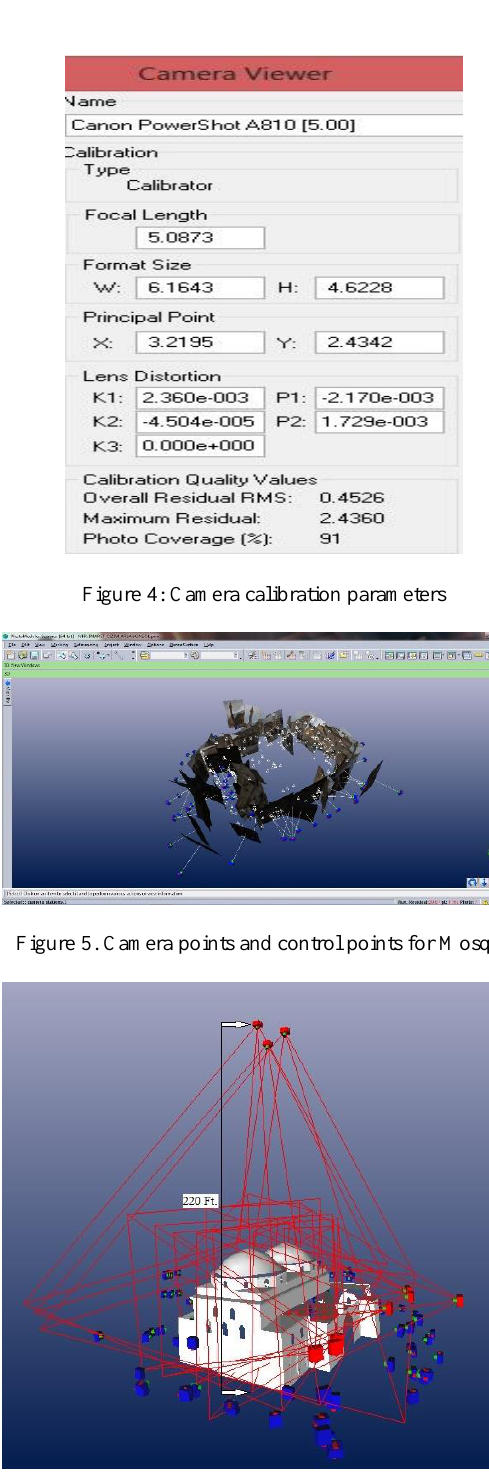
Figure 6. Photograph angles and